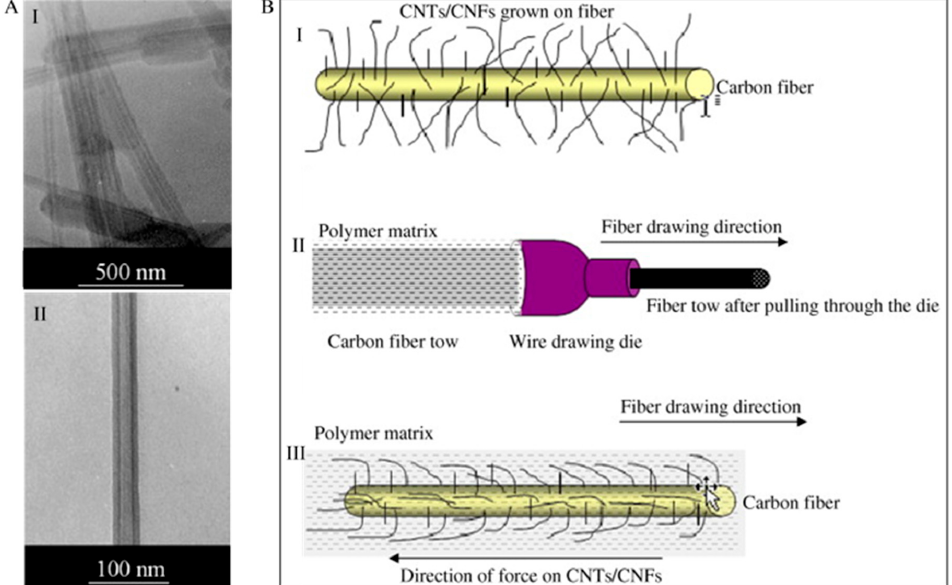
Figure 1. ( A ) TEM images of the carbon nanotubes: I. aligned bundles of hollow-core MWCNTs; II. isolated MWCNTs. ( B ) Schematic diagram illustrating: I. carbon fibre after the growth of CNTs/CNFs; II. fibre dipped in polymer matrix and drawn through the die to fabricate a single fibre tow composite specimen; III. carbon fibre after drawing through the die showing partial alignment of CNTs/CNFs along the fibre axis due to the viscous force of the matrix and the force due to the smallness of the orifice. Reprinted with permission from ref. [91], Copyright 2011 Elsevier Ltd.